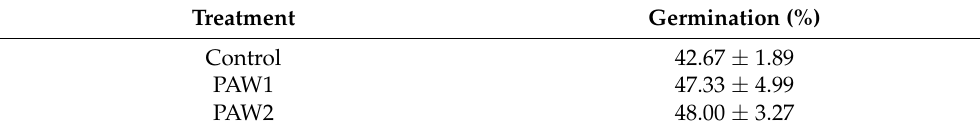
Table 3. Effect of PAW treatment on the germination of Triticum aestivum L. cv. Glosa caryopses. Treatment